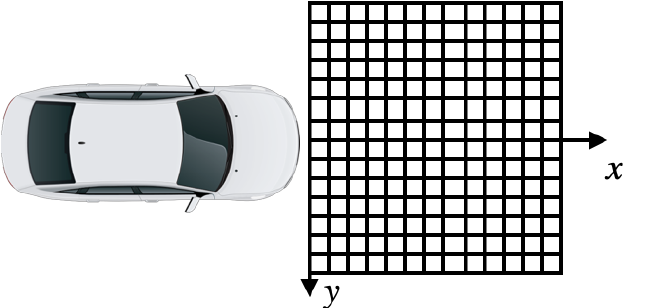
Figure 5. Back projection grid representation in a Cartesian reference system for a forward looking Automotive SAR.